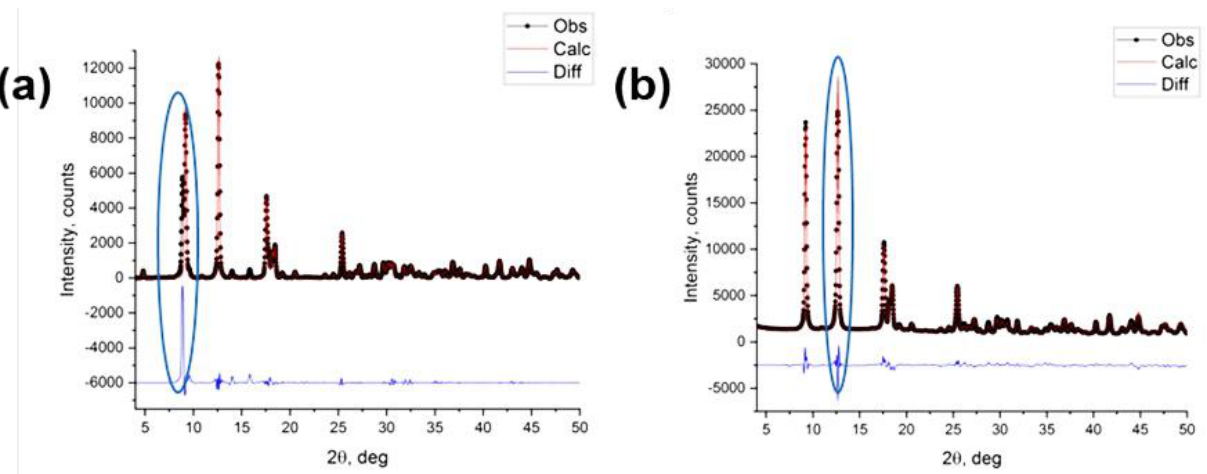
Figure 10. Observed, calculated and differential powder patterns of MIL-53(Fe)/GO ( a ) and MIL-53(Fe) ( b ) samples after full-profile analysis. Angular scale was recalculated to Cu K α radiation.